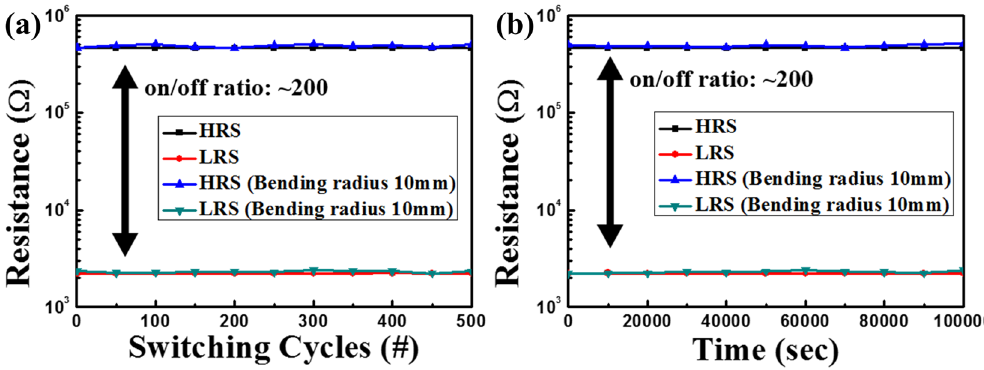
Figure 5. ( a ) Endurance and ( b ) retention characteristics of the FT-RRAM at flat and bent states, respectively, measured at a V READ = − 0.2